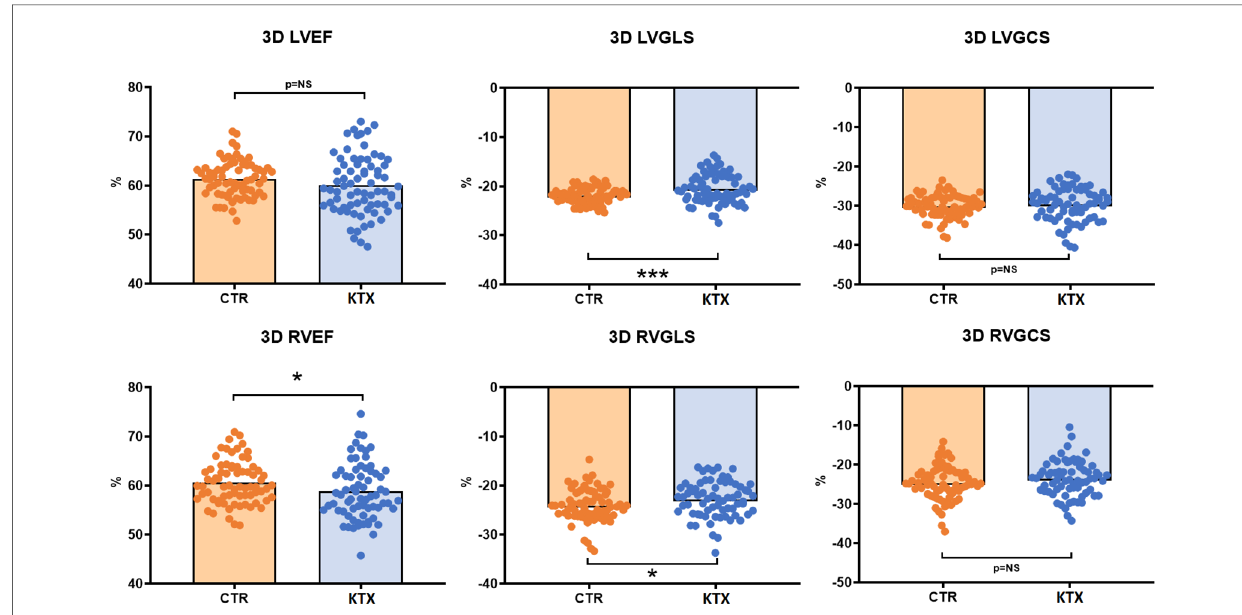
FIGURE 2 3D ventricular functional parameters of the two study groups. LVGLS was impaired in the transplant recipients, while LVEF and LVGCS did not differ. RVEF and RVGLS were signi fi cantly reduced in the transplant patients, while the RVGCS was comparable between the groups. LVEF, left ventricular ejection fraction; LVGLS, left ventricular global longitudinal strain; LVGCS, left ventricular global circumferential strain; RVEF, right ventricular ejection fraction; RVGLS, right ventricular global longitudinal strain; RVGCS, right ventricular global circumferential strain; CTR, control group; KTX, kidney transplant group; *= p <0.05; **= p <0.01; ***= p